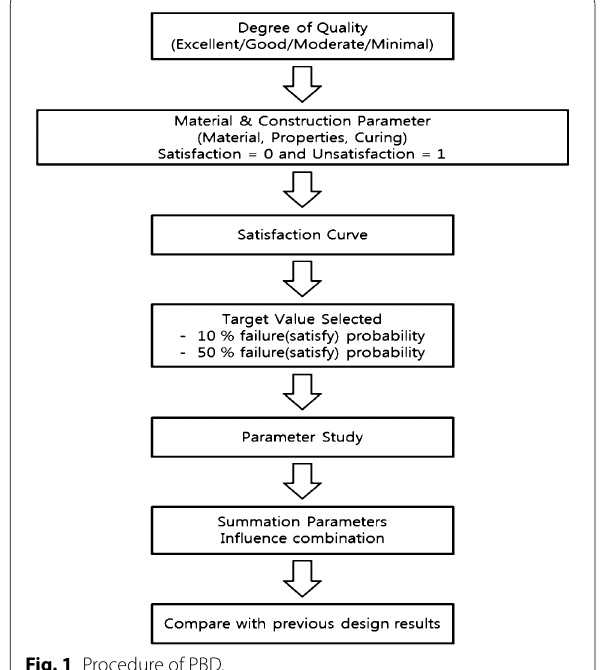
Fig. 1 Procedure of PBD.